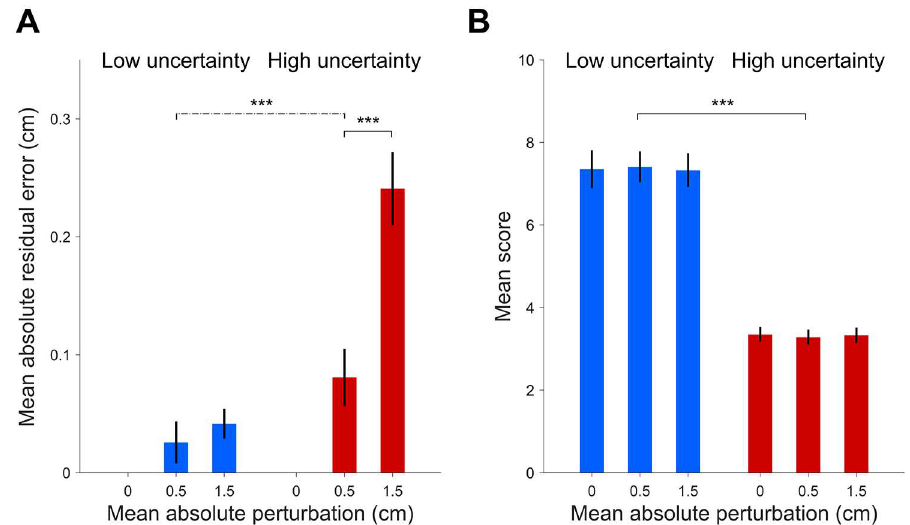
Fig 3. Participants’ mean absolute residual errors and mean scores. A: Mean absoluteresidualerror (mean ± SE across subjects; residual errors are computedafter removing the residualerror for the 0 perturbationcondition) by perturbationsize (0, ± 0.5, ± 1.5 cm) and trial uncertainty (Low, High). These data are the same as in Fig 2A, here shown in absolute value and aggregatedby perturbation size. B: Participants’ mean scores (mean ± SE betweensubjects) by perturbationsize and trial uncertainty. Even though the residual errors (panelA) are significantly different from zero and significantly modulated by perturbationsize ( p < .001) and the interaction between the uncertaintyand perturbationsize ( p < .001), the scores (panelB) are significantly affected only by the trial uncertainty ( p <